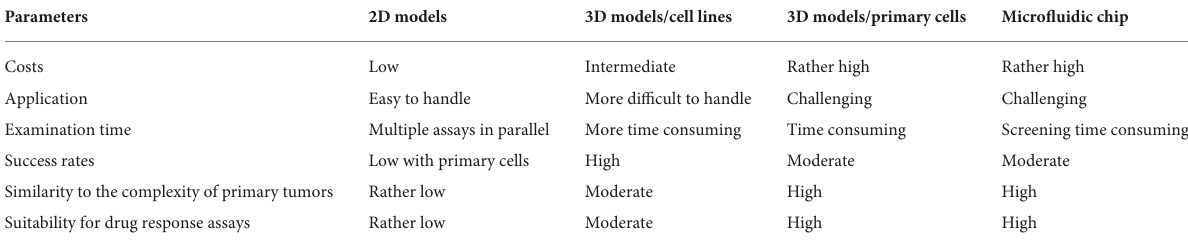
TABLE 1 Different in vitro model systems as tool for monitoring growth properties, tumor immune cell interaction, and treatment options.